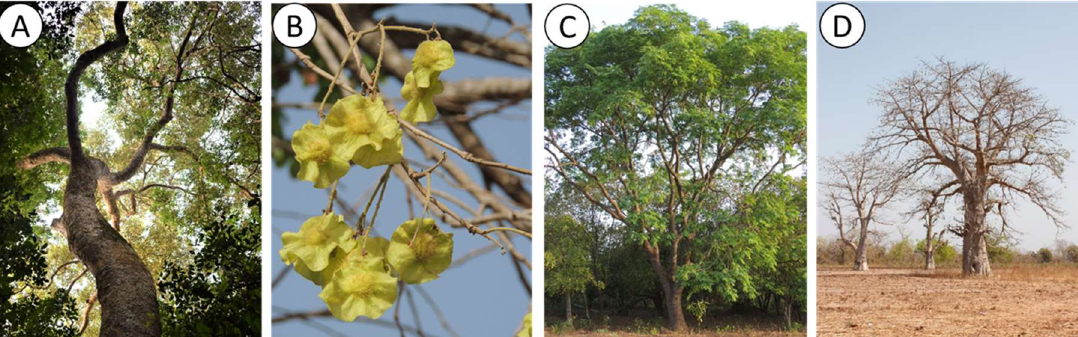
Figure 2. Plants of the Guinea-Bissau’s flora reported in the early reports. ( A ) Guinea plum ( Parinari excelsa Sabine) reported by Valentim Fernandes 1506–1507; ( B ) African rosewood ( Pterocarpus erinaceus Poir.); ( C ) locust bean tree ( Parkia biglobosa (Jacq.) R.Br. ex G.Don), mentioned by André Álvares d’Almada in 1841; and ( D ) the emblematic baobab tree— Adansonia digitata L.—referred during the 17th century, in travel accounts provided among others by Francisco de Lemos Coelho. The generic name honoring Michel Adanson. (Photos by L. Catarino).